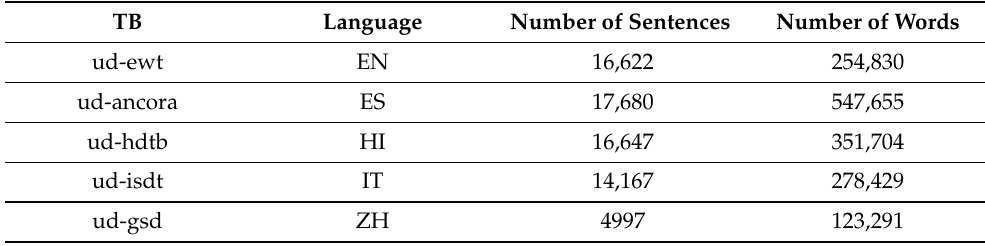
Table 3. The five treebanks for English, Spanish, Hindi, Italian, and Chinese that have been used in the